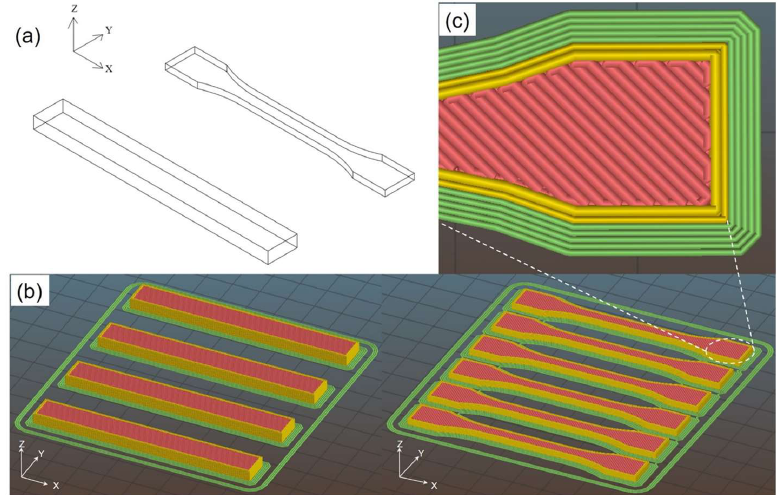
Figure 1. Extruded filaments of neat ABS, ABS/MCF, ABS/MCF/CNT, and ABS/MCF/GNP composites. Each composition is detailed in the inset.